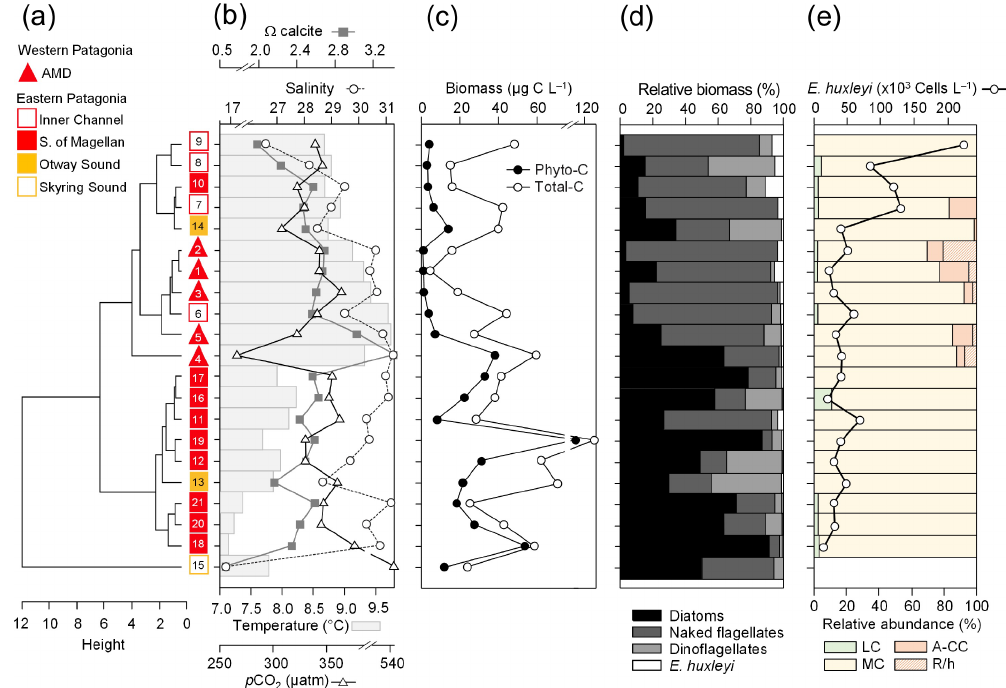
Figure 3. Physical and chemical conditions, carbon biomass by microplankton and phytoplankton assemblages, and abundance and calcifi- cation level of E. huxleyi recorded in surface waters of southern Patagonia during the late austral spring 2015. (a) Hierarchical clustering on salinity, temperature, pH, p CO 2 , and (cid:127) calcite surface values on 21 water samples collected for plankton analysis, (b) salinity, temperature, (cid:127) calcite, and p CO 2 levels. (c) Total carbon biomass by the nano- and micro-plankton assemblages (Total-C, all items between 5–200µm in length) and phytoplankton assemblages (Phyto-C, diatoms + coccolithophores). (d) Relative carbon biomass by diatoms, naked flagellates, dinoflagellates, and E. huxleyi . (e) Total abundances of E. huxleyi and relative abundances of four E. huxleyi morphotypes. All samples were taken < 5m in depth. Stations 5–7, 11–13, and 18–21 were conducted at night. LC: E. huxleyi lightly calcified A morphotype; MC: E.